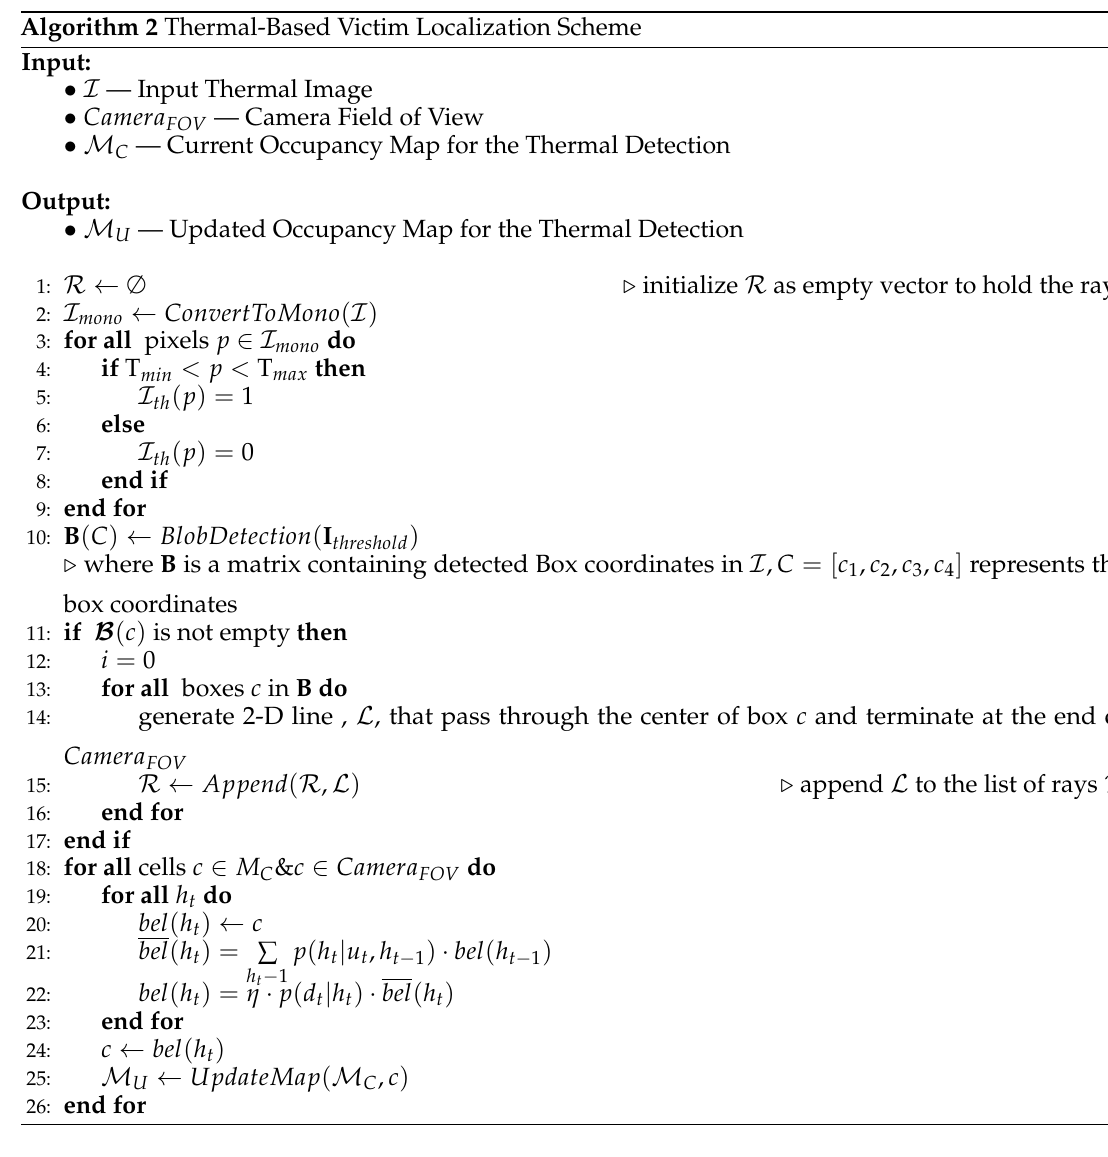
Algorithm 2 Thermal-Based Victim Localization